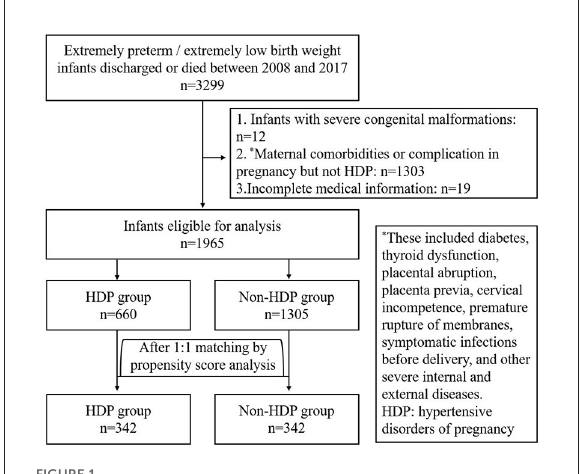
FIGURE1 Flow chart of enrolment of the study